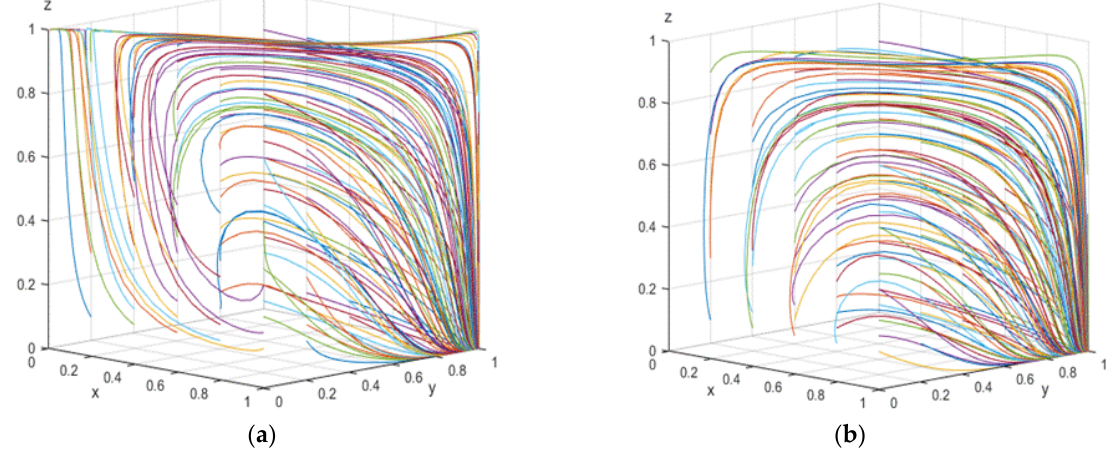
Figure 5. ( a ) The result of evolutions of array 1. ( b ) The result of evolutions of array 2.